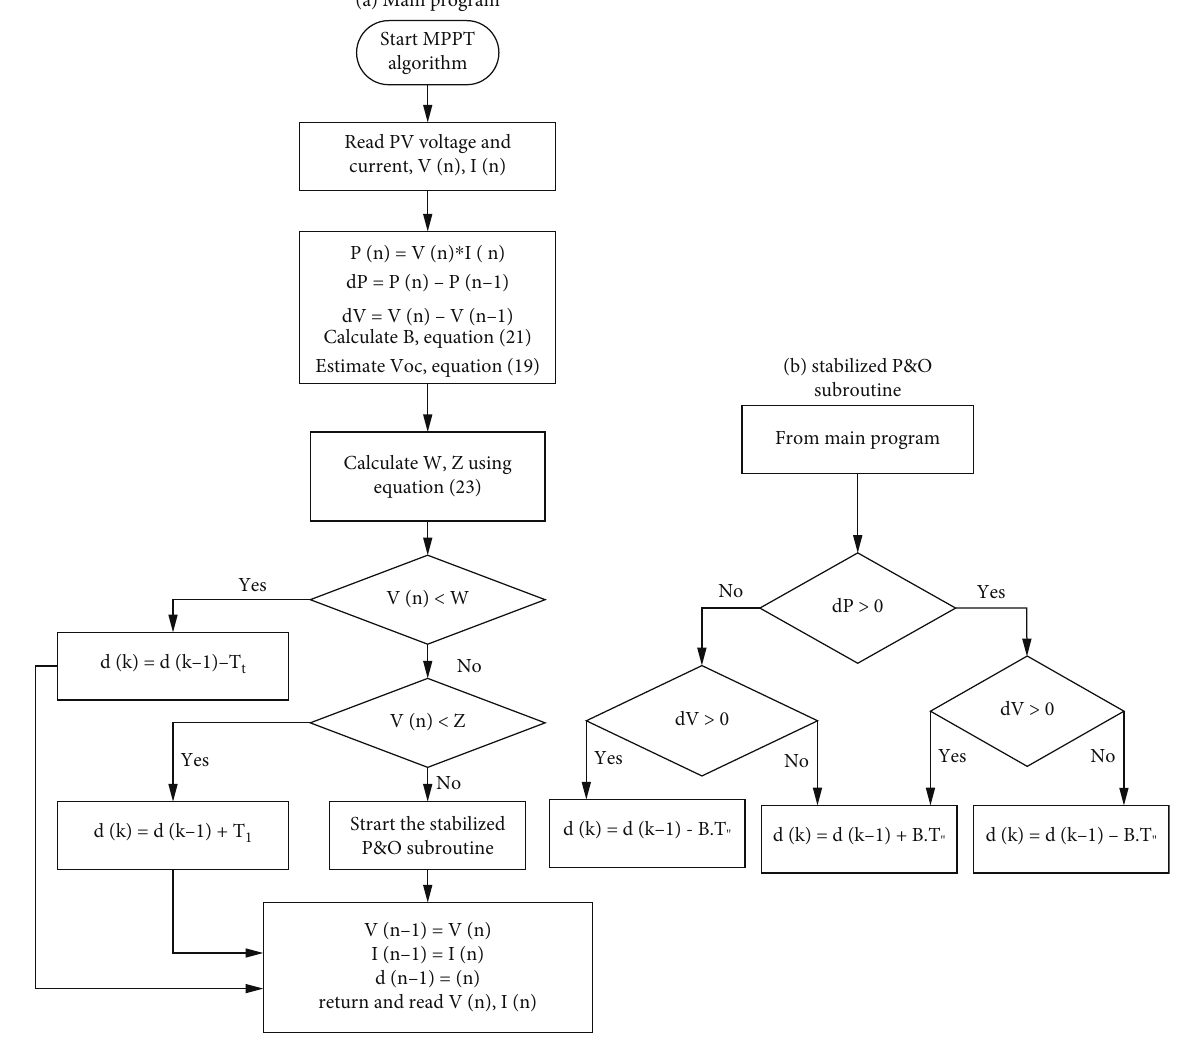
Figure 7: Flowchart of the proposed enhanced P&O algorithm.